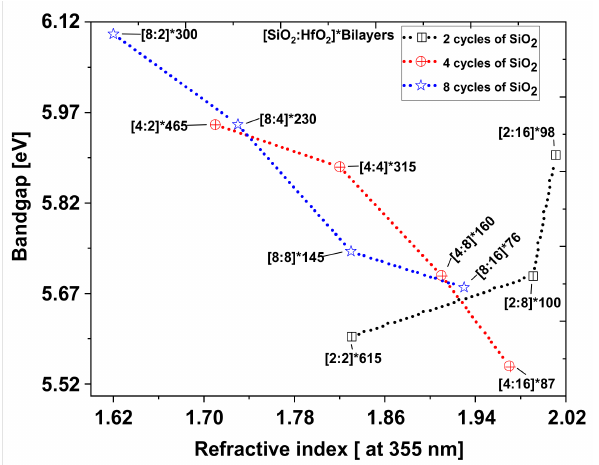
Figure 5. Optical bandgap as a function of refractive index at 355 nm